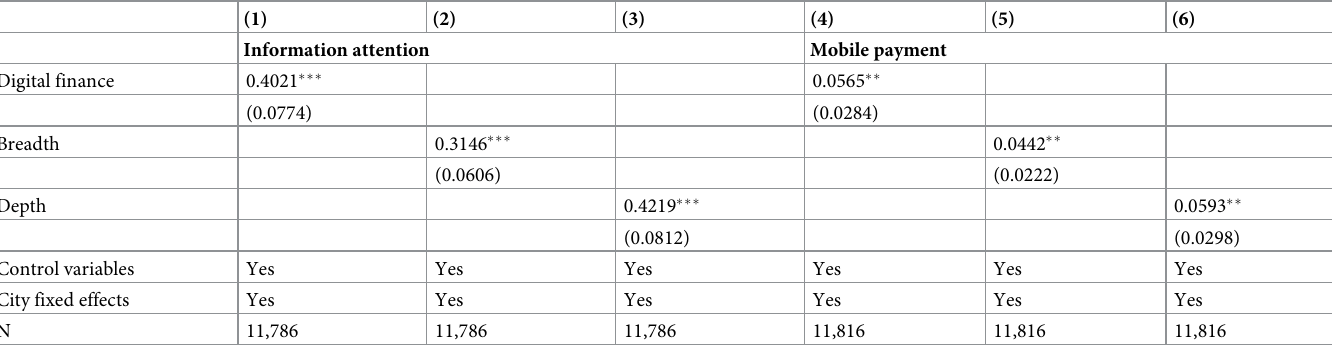
Table 6. Information constraints of digital finance.